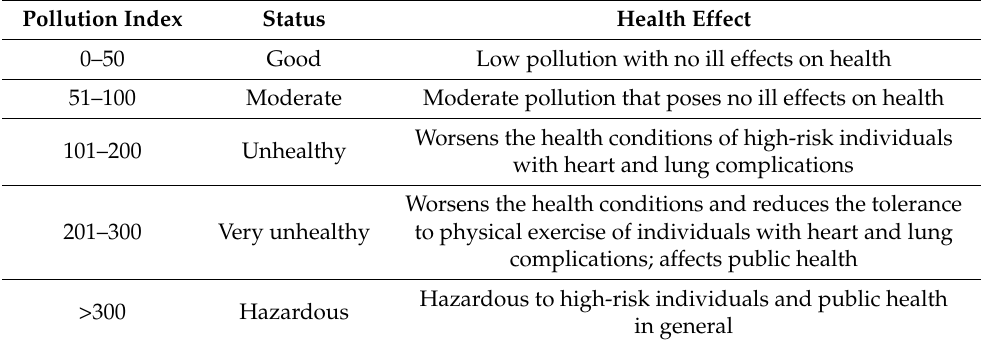
Table 1. Air quality statuses corresponding to API